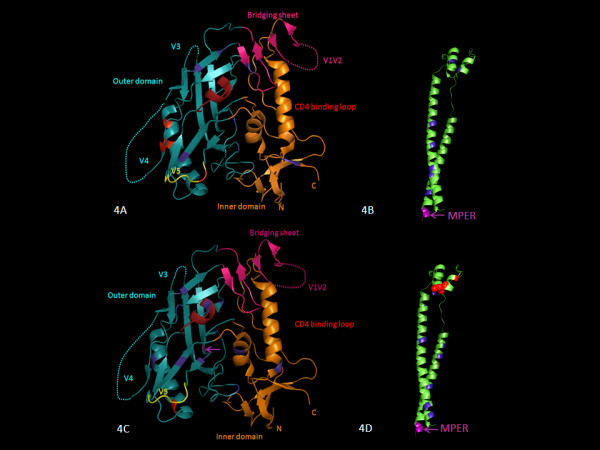
Three dimensional structural illustrations of positions associated with positive negative and neutral selection. Locations were mapped onto a model of gp120 based on the X-ray structure of the gp120 core in complex with sCD4 and 21c Fab (3LQA.pdb) for slow progressors - Figure 4A and for progressors - Figure 4C. V1V2 and V3 loops were drawn onto the core for completeness. In the orientation shown, the cellular and viral membranes would be located above and below the protein respectively. Figure 4B and 4D represent ribbon structures of gp41 for slow progressors and progressors with the MPER region highlighted. Cartoon diagrams showing locations under positive selection, as determined by dN/dS ratios for subtype C sequences. Red indicates strong positive selection (dN/dS >4) as shown above in HXB2 positions 87, 336, 340, 396, 410 and 460 for slow progressors (Figure 4A) and in progressors at positions 350 (Figure 4C) and 607, 612 and 641 in Figure 4D. Blue indicates strongly negatively selected positions (<-3). Purple and purple arrows denote changes in putative functional sites as shown in Figures 4B, 4C and 4D. Spheres indicate signature sequence differences. It should be noted that the gp120 core crystal structures which were modeled on the 3LQA.PDB structure, include amino acid residues from HXB2 position 86-491. The gp41 structure based on 1ENV.pdb includes amino acid residues from HXB2 position 541-662. Therefore all the positively and negatively selected sites are not indicated on the gp120 and gp41 structures.